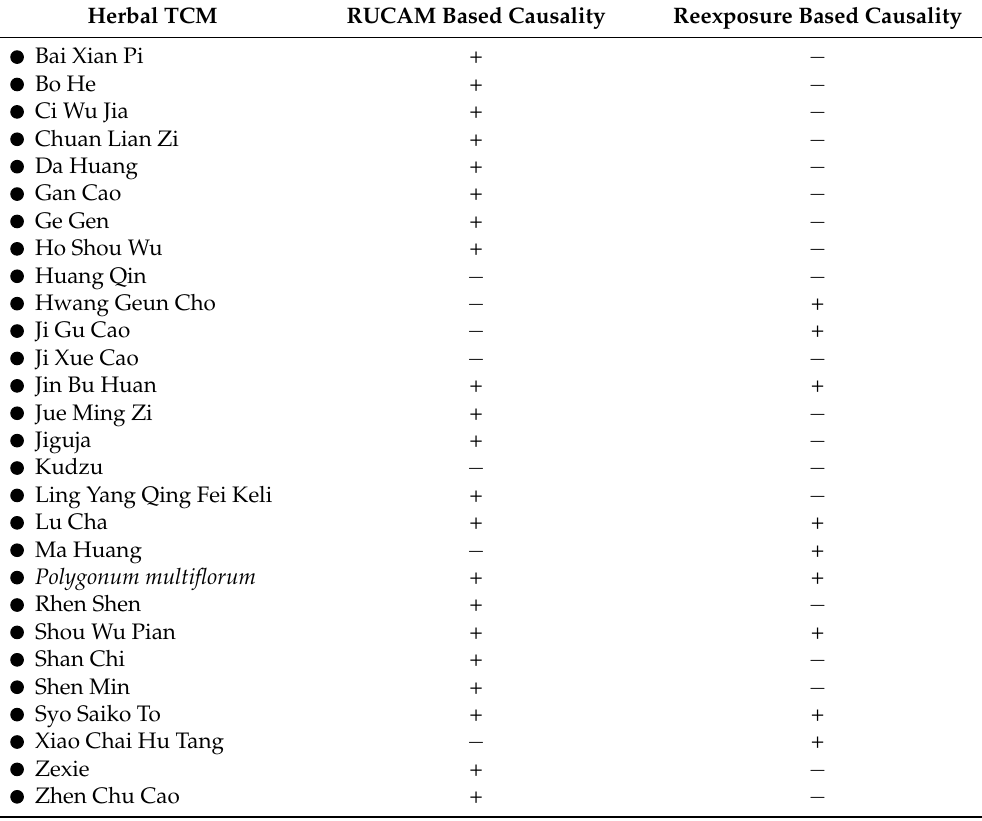
Table 9. Causality assessment by RUCAM and/or positive reexposure tests in cases with assumed herbal hepatotoxicity by Traditional Chinese Medicine